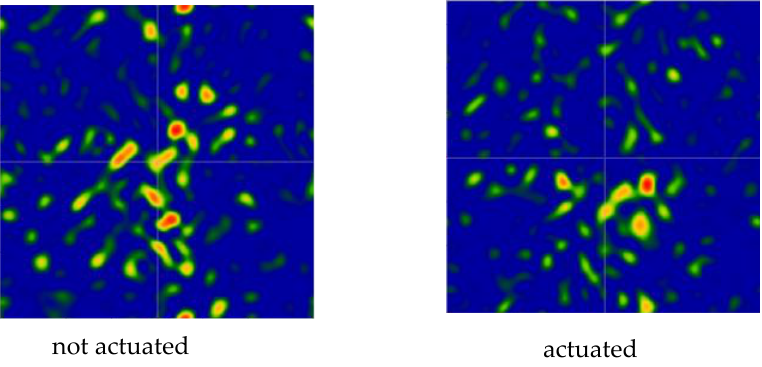
Figure 14. As an example, 2 “qualitative” FFDPs of sample 2, mirror d, computed through the interferometer software in arbitrary units, at the operational wavelength of 633 nm.